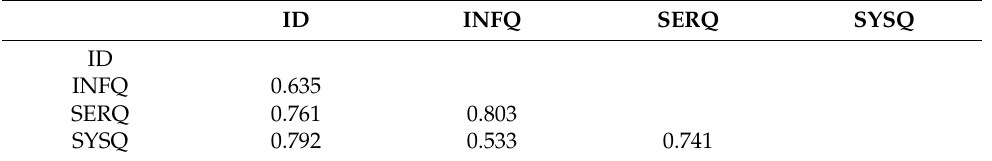
Table 4. Heterotrait-monotrait ratio of correlations criterion.